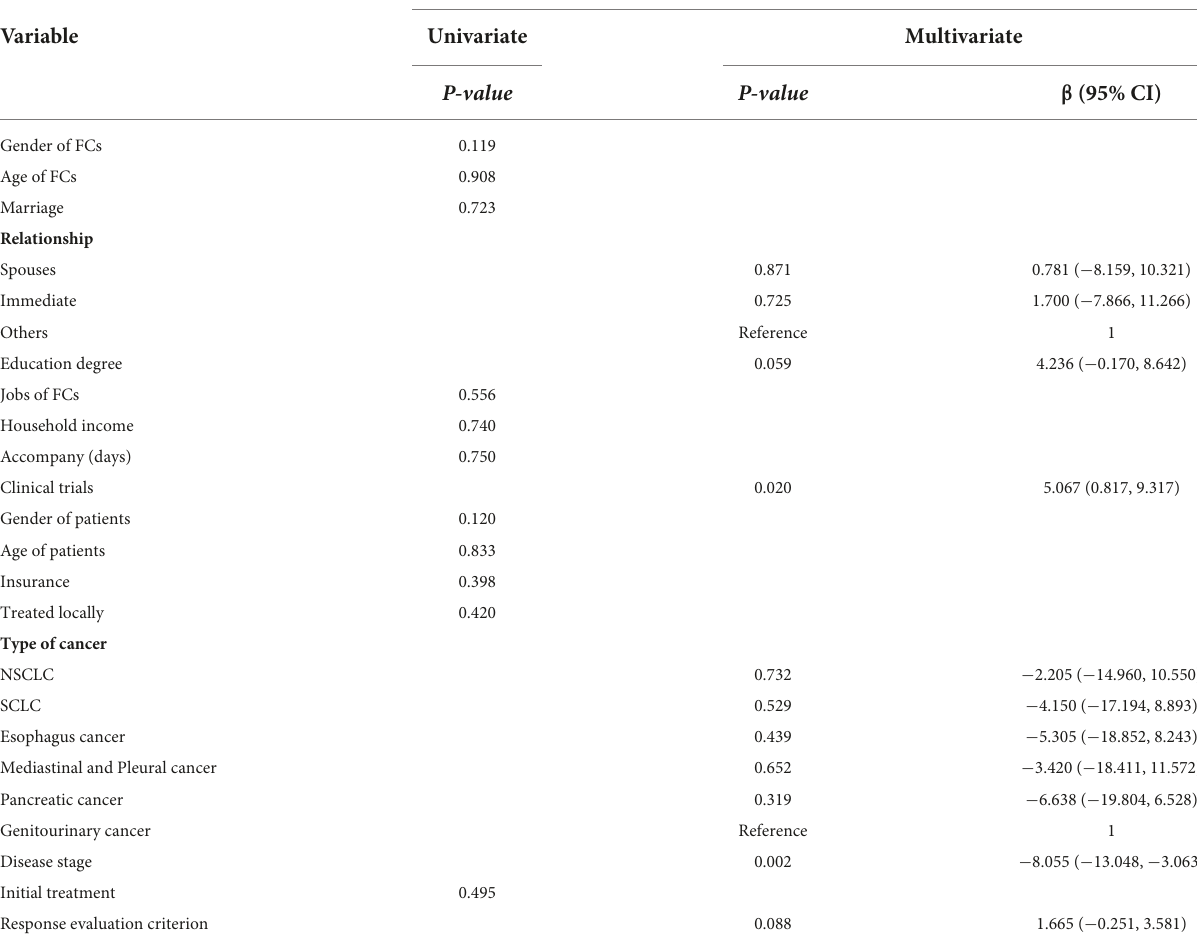
TABLE 3 Univariate and multiple linear regression analysis of MCS according to